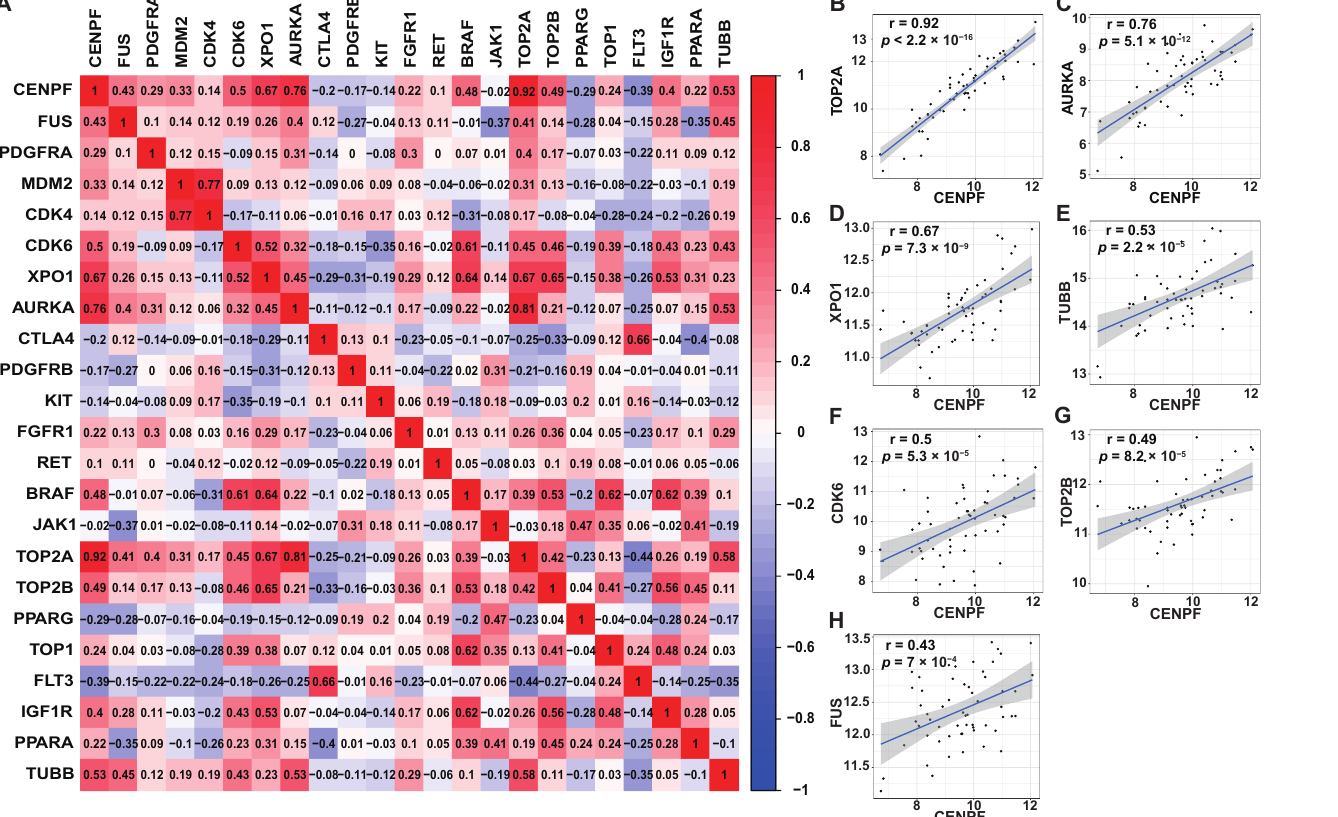
Figure 8. Correlation analysis between CENPF and previously identified therapeutic targets for LPS. ( A ) Correlation matrix diagram. ( B – H ) CENPF expression was significantly positively correlated with several previously identified therapeutic targets for LPS clinical treatment